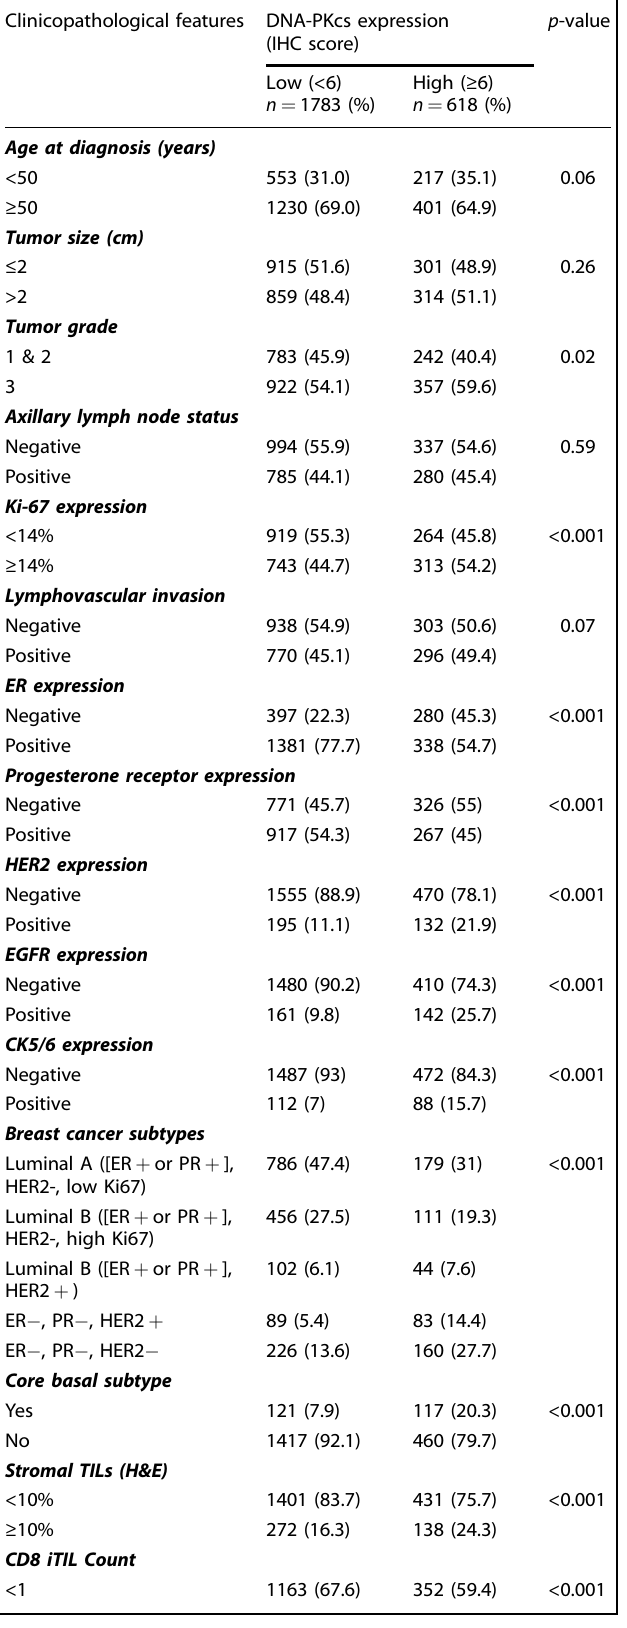
Table 1. Association of DNA-PKcs expression with clinicopathological features in the British Columbia Cancer series. Clinicopathological features DNA-PKcs expression (IHC